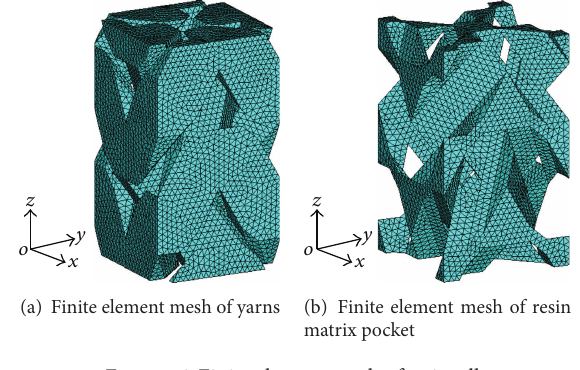
Figure 6: Finite element mesh of unit